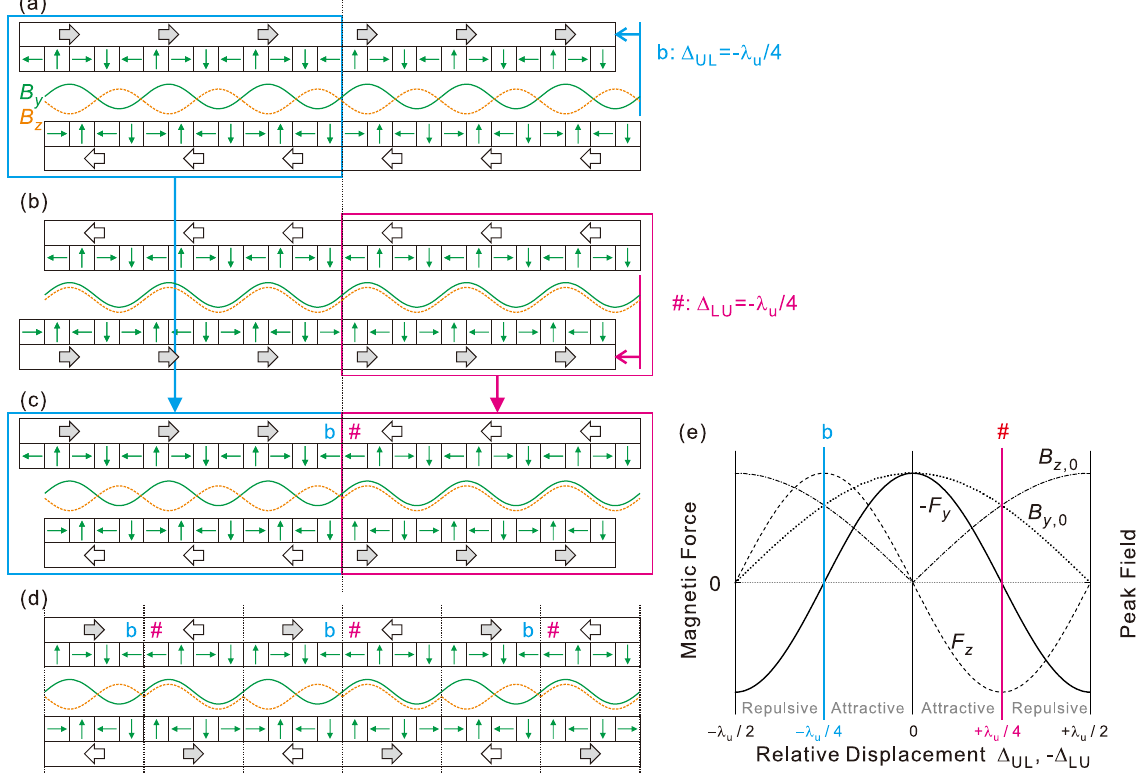
FIG. 2. Conceptual drawing of the PCU. (a) The upper and (b) the lower phase-shifted configuration are combined as (c) the PCU with D ¼ 2 and (d) the PCU with D ¼ N the symbol ♯ indicates that the lower magnets are displaced by Δ